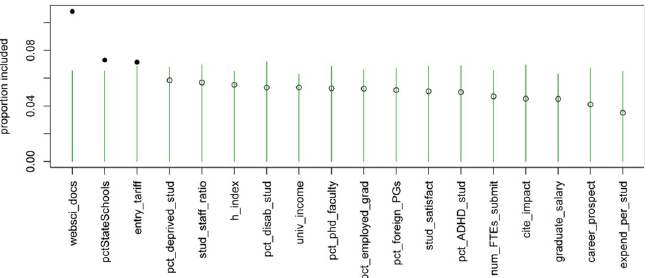
Fig 2. Variables ranked by order of predictive importance for GPA in the REF. Green lines indicate thresholds for inclusion into the model. Solid dot on top of green line indicates variable was selected as a significant predictor of GPA.